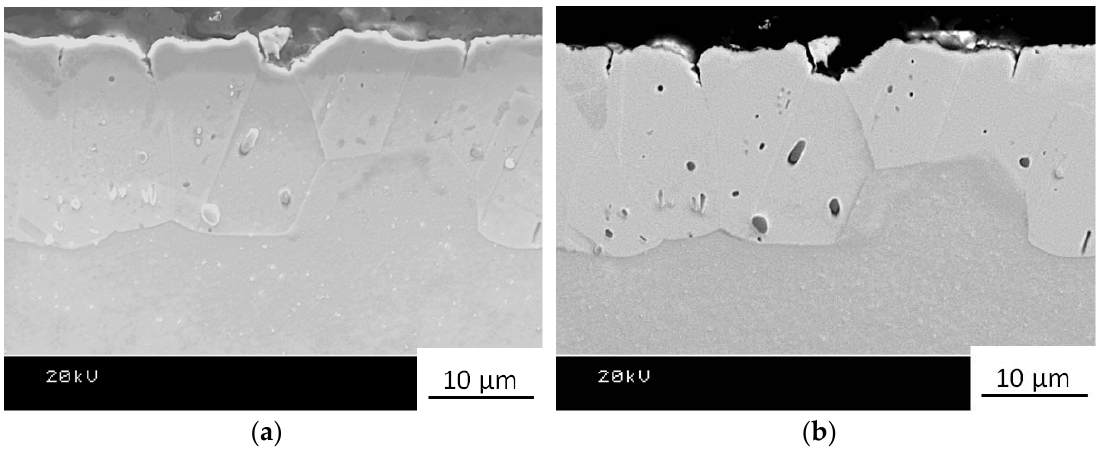
Figure 18. Cross section through the surface after corrosion testing imaged in: ( a ) SE; ( b ) BSE.